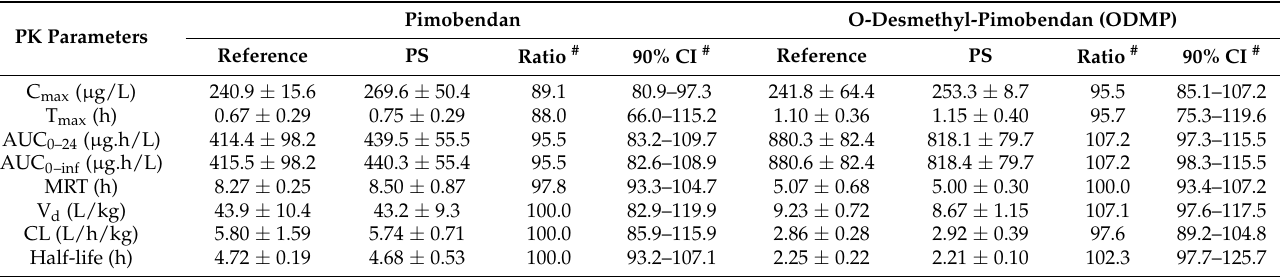
Table 1. Comparison of pharmacokinetic parameters between pimobendan oral solution formulation (2.5 mg/mL) and reference solution formulation (3.5 mg/mL) after 0.3 mg/kg oral administration in healthy beagle dogs (n = 4 for each formulation).